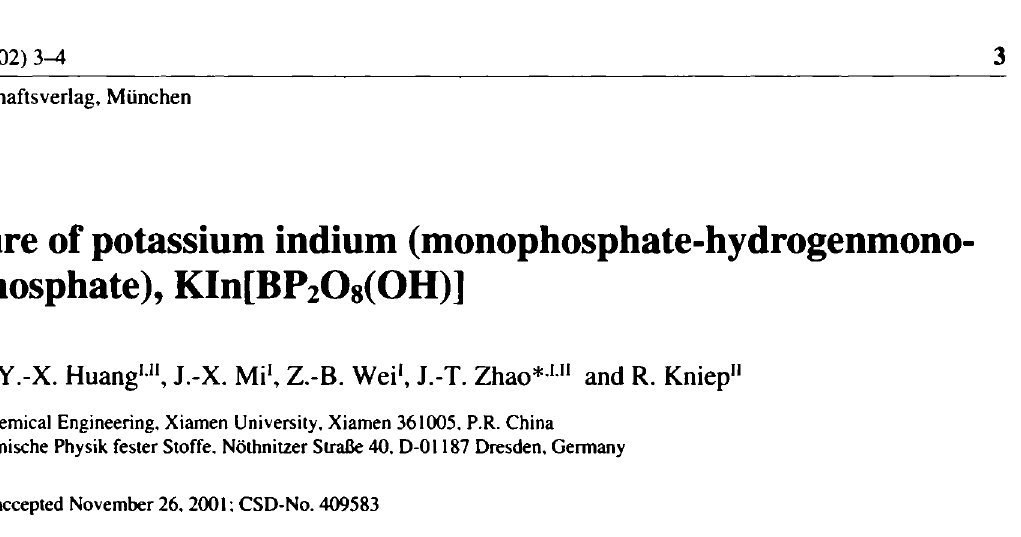
Table 1. Data collection and handling. Crystal: